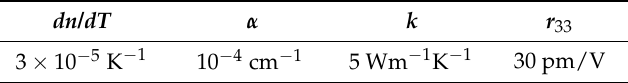
Table 2. Characteristic parameters of LN crystal